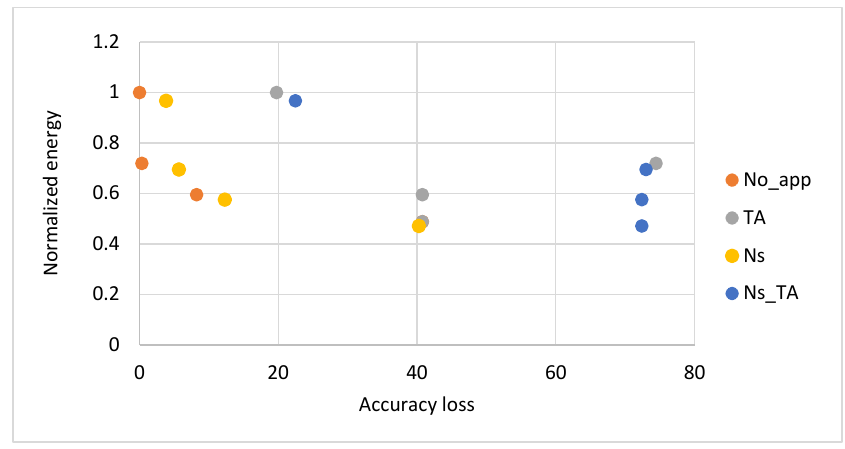
Figure 6. Approximation results for SVHN dataset, Noapp: No approximation, Ns: Neuron skipping, TA: Truncated Accumulation